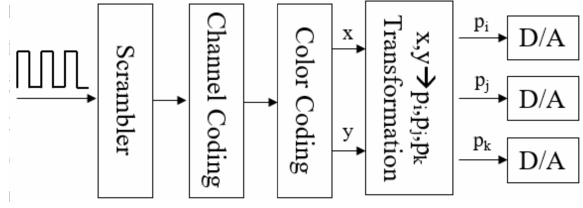
Figure 8. Schematic diagram of the CSK signal generation.